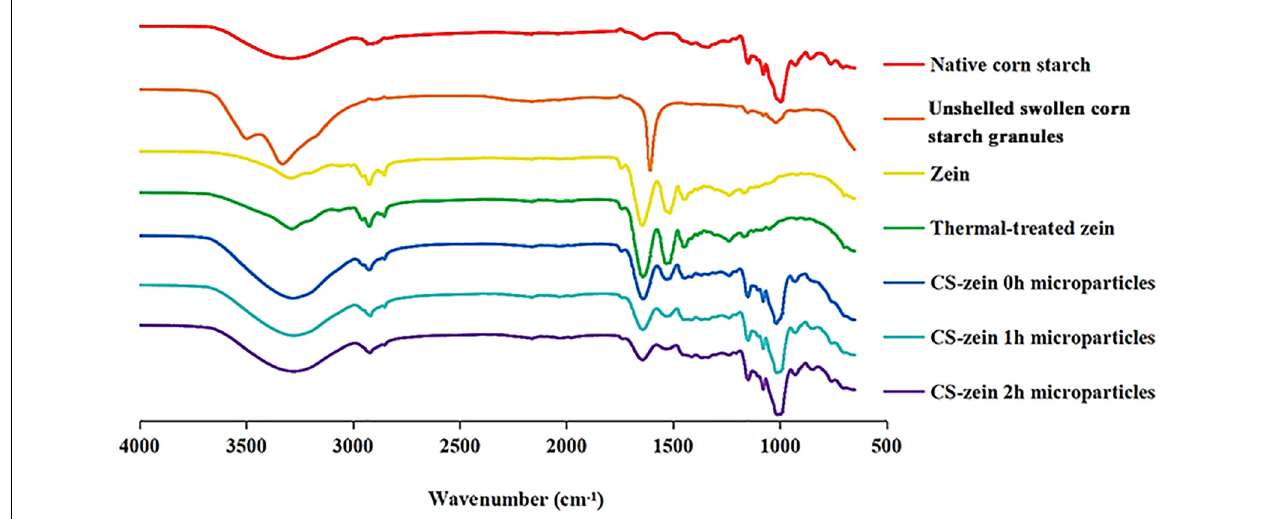
FIGURE 6 | FTIR spectra of native corn starch, unshelled swollen corn starch granules, zein, thermal-treated zein and core-shell starch/zein microparticles crosslinked by TGase for different times (0, 1, and 2 h). TABLE 3 | The onset (To), peak (Tp) and conclusion (Tc) temperatures and enthalpy change ( (cid:49) H) of native corn starch, unshelled swollen corn starch granules, and core-shell starch/zein microparticles crosslinked by TGase for different times (0, 1, and 2 h). Sample To/ ◦ C Tp/ ◦ C Tc/ ◦ C (cid:49) H/(J/g)